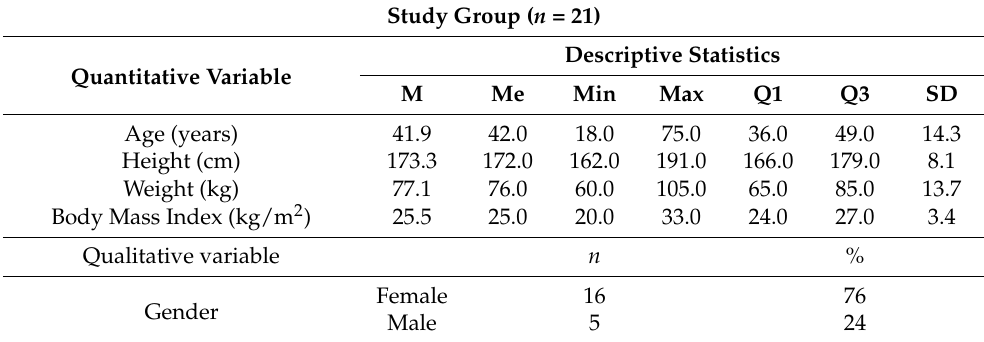
Table 1. Baseline